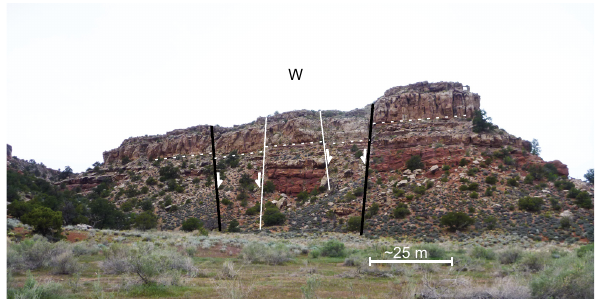
Figure 18. Graben in Cross Canyon. Black lines show main graben- bounding faults. White lines show two conjugate faults cutting through the graben floor. Dashed line illustrates marker horizon. Example for intra-graben faulting.